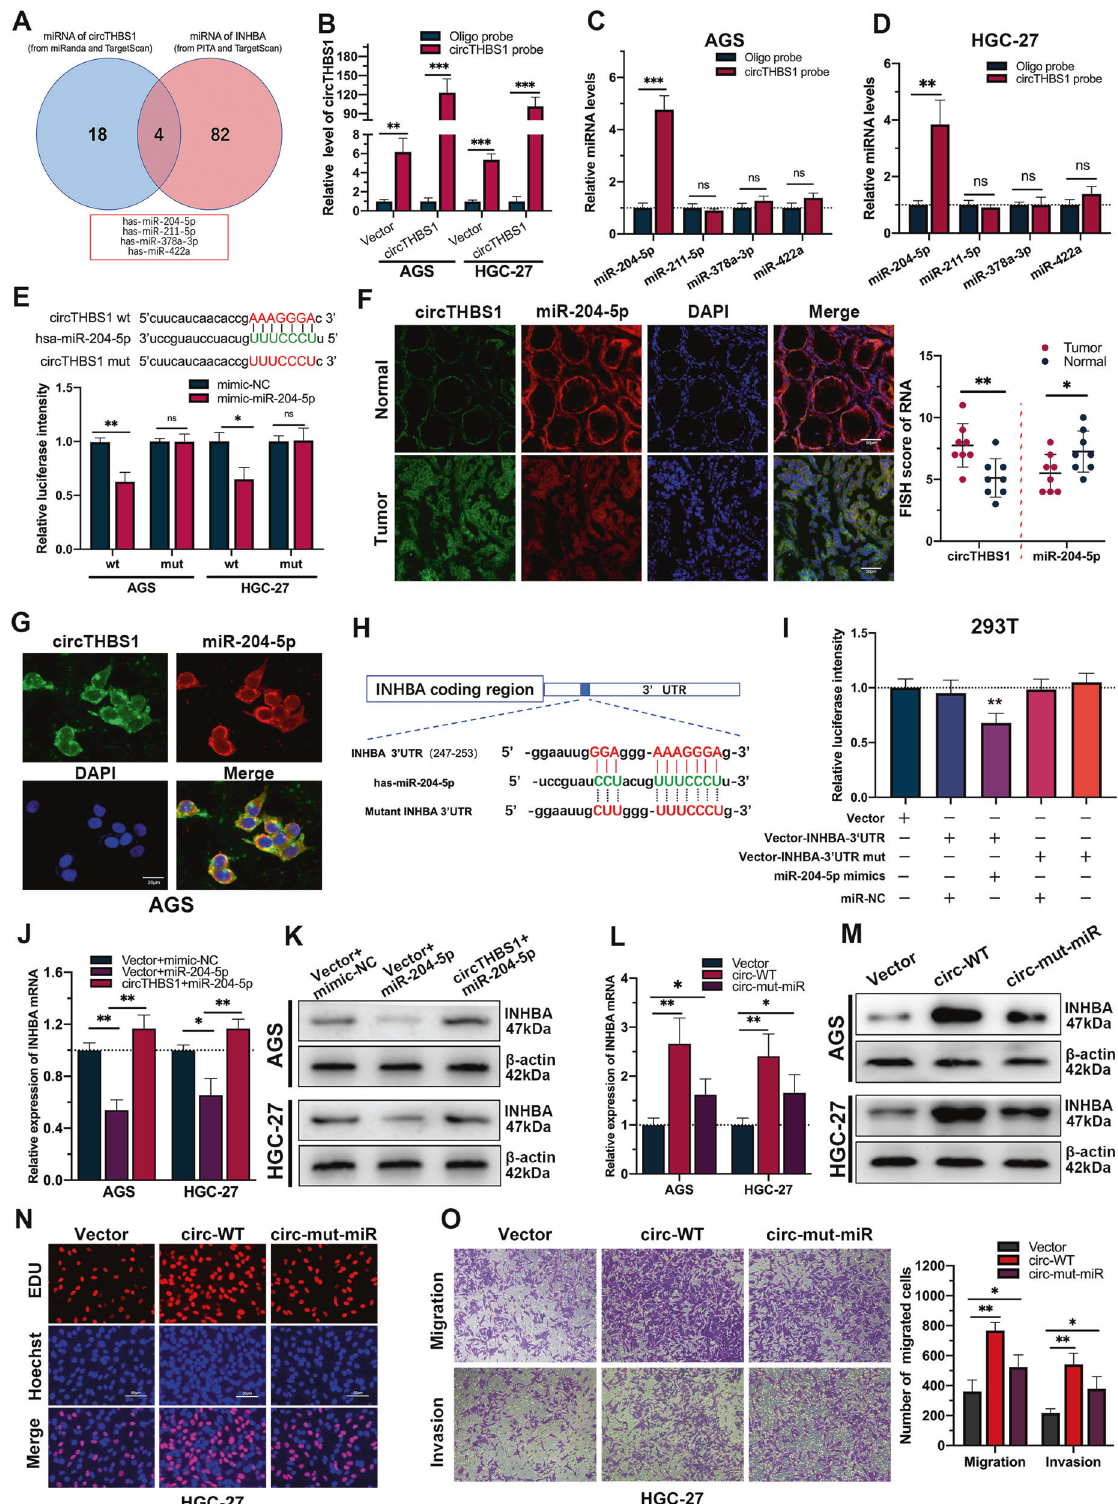
HuR was con fi rmed by RNA pull-down and RIP assays. As the results showed, HuR proteins in AGS and HGC-27 cell lysates were pulled down by the circTHBS1 probes (Fig. 5C), and circTHBS1 were also precipitated by the anti-HuR antibody (Fig. 5D). According to the CatRAPID (http://service.tartaglialab.com) Cell Death and Disease (2022)